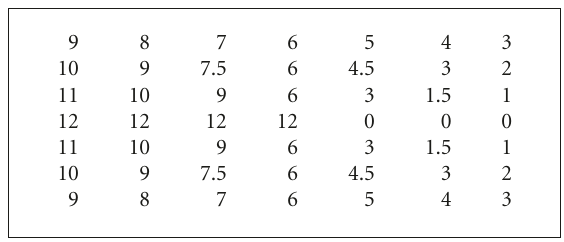
Figure 2: 7 × 7 penalty matrix W Penalty (direction = 1) in the estimated direction → (0 ◦